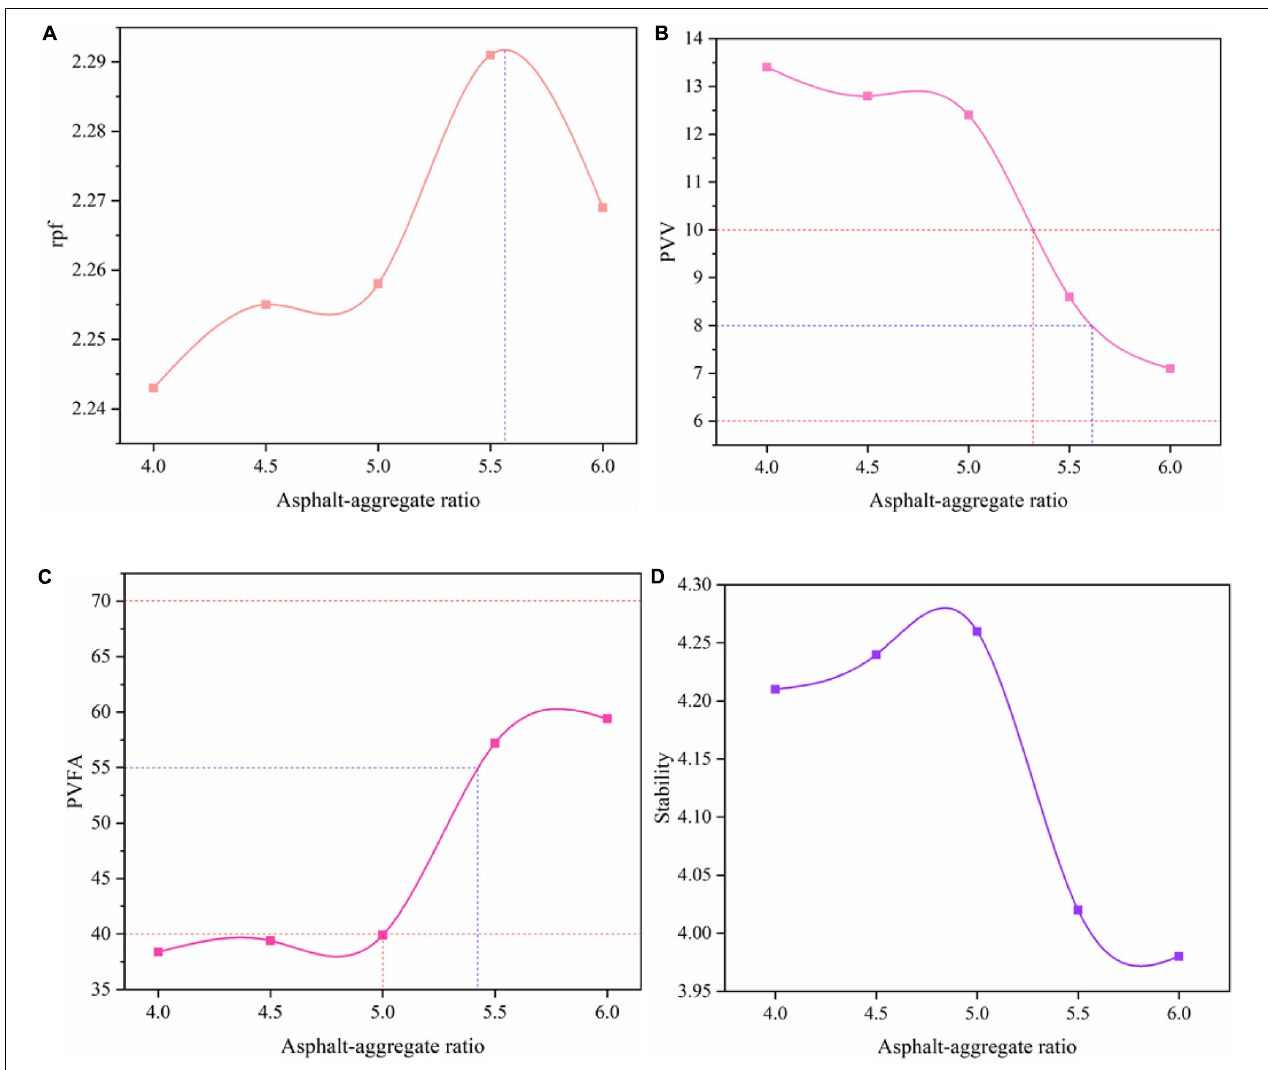
FIGURE 3 | (A) Relationship between asphalt aggregate ratio and rpf; (B) relationship between asphalt aggregate ratio and PVV; (C) relationship between asphalt aggregate ratio and PVFA; (D) relationship between asphalt aggregate ratio and